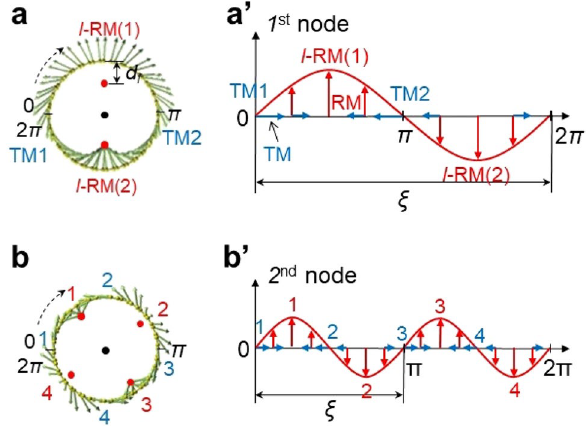
Figure 4. Conceptual explanation of RTMs and variation of depth of focus with node. ( a , b ) 1st and 2nd node RTMs for the concentric tube structure. The red solid dots indicate the decentered focus of Eigenvectors of l -RM. d f is a depth of focus, the distance between the focus and the tube wall. The black dot in ( a , b ) indicates a focus of RBM where the depth of focus is r . ( a’ , b’ ) Sine curves of the RTMs where ξ is defined as a cycle of TM-RM-TM-RM-TM. Red and blue arrows indicate radial and transverse components deconvoluted from the slow varying Eigenvectors, respectively. Red and blue numbers in a-b’ indicate the number of l -RM and l -TM, respectively.